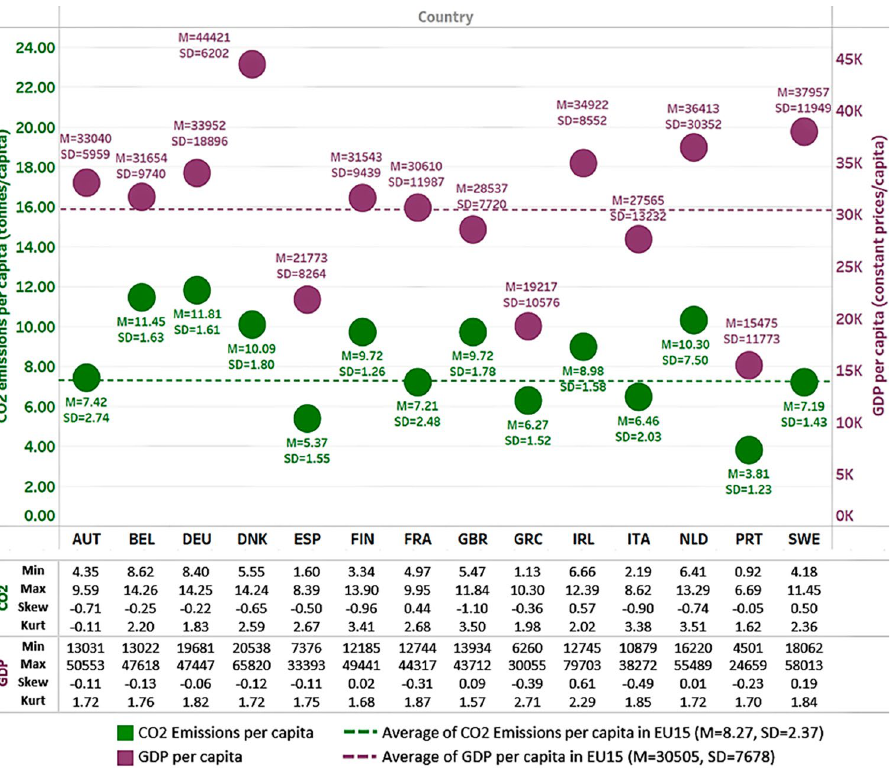
Figure 2. Descriptive statistics of CO2 emissions per capita and GDP per capita in the EU15